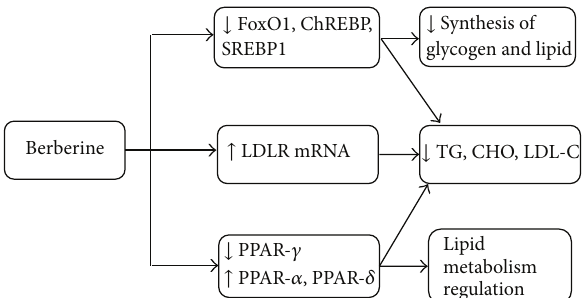
Figure 3: Main mechanisms of BBR on lipid metabolism. Note: FoxO1: Forkhead transcription factor O1; ChREBP: carbohydrate responsive element-binding protein; SREBP1: sterol regulatory element-binding protein-1; LDLR mRNA: low-density lipoprotein receptor m ribonucleic acid; TG: triglyceride; CHO: cholesterol; LDL-C: low-density lipoprotein cholesterol; PPARs: peroxisome proliferator-activated